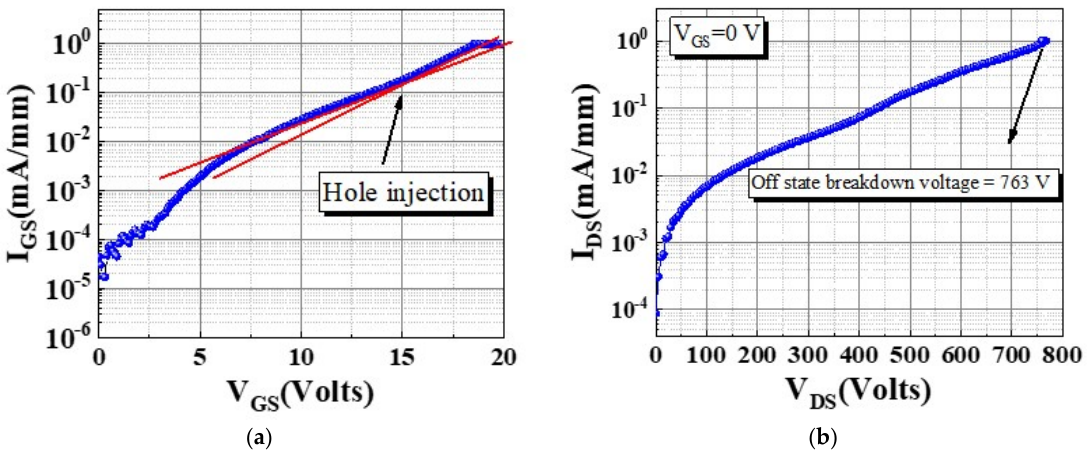
Figure 3. ( a ) I GS − V GS characteristic and ( b ) off − state breakdown voltage measurement of the device.